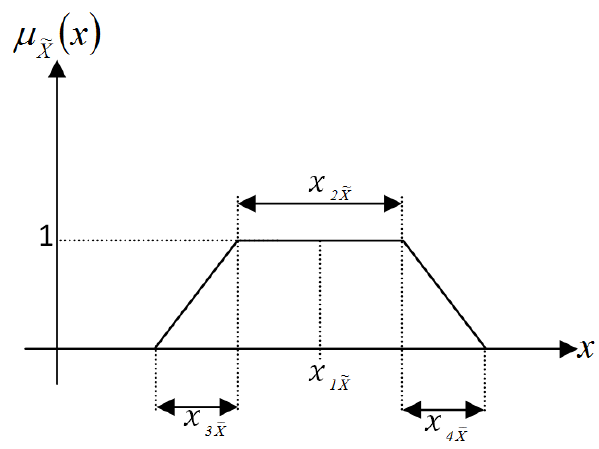
Figure 1. Parameterization of TFN.